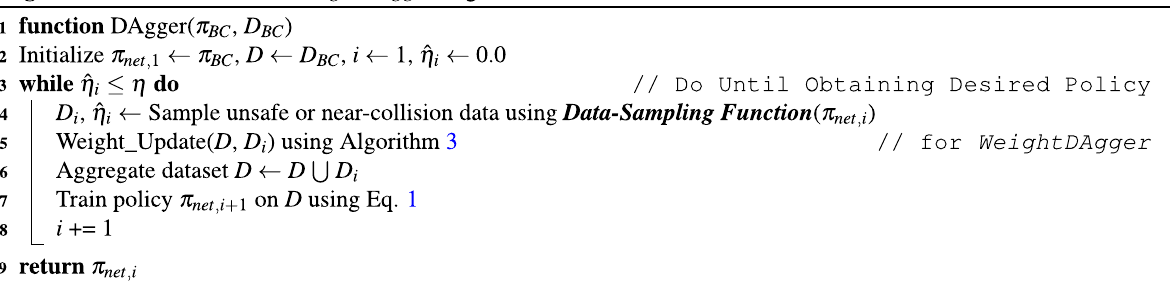
Algorithm 1 represents the basic structure of DAgger . First, DAgger initializes the policy π net , i = 1 and dataset D as those obtained from behavior cloning . The DAgger iteration i and ˆ η i representing the performance of the trained policy π net , i are initialized. When the iteration is started ( i = 1), the additional dataset D i is collected by the data-sampling function as described in the next subsection (line 4 in Algorithm 1), which samples the only data for unsafe or near-collision situations. Following the driving via the data-sampling function , the additional dataset D i collected is aggregated to the existing dataset D (line 6). The aggregated dataset D is used to retrain the policy π net with (1) (line 7). After training, a policy π net , i + 1 that causes fewer unsafe or near-collision situations than